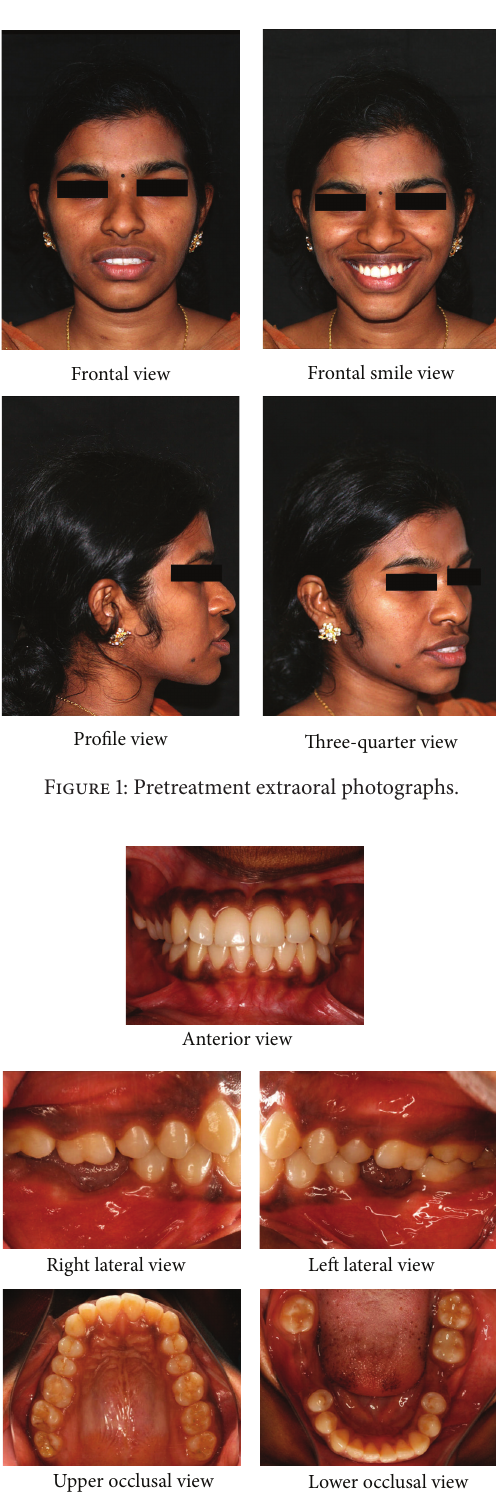
Figure 2: Pretreatment intraoral photographs. medium force NiTi close coil springs in lower arch and active tiebacks in upper arch.